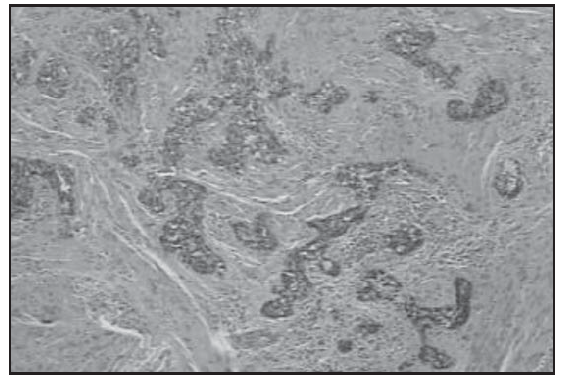
Figura 5 – Região profunda da neoplasia: múltiplos blocos celulares de células peque- nas, indiferenciadas, em meio a estroma pouco reativo (HE,